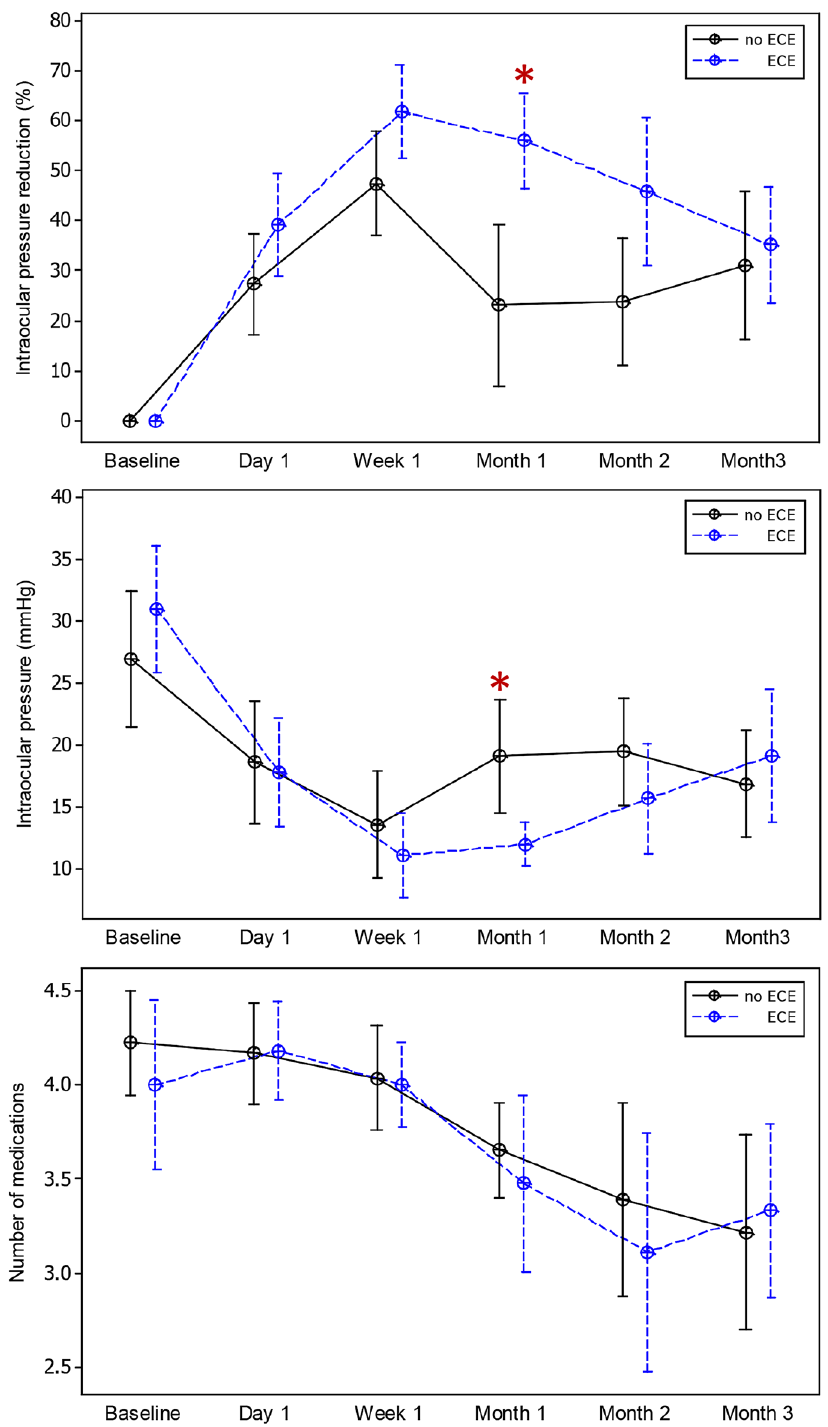
Figure 2. Interval plots of micropulse transscleral laser therapy outcomes during 12 weeks. (Top) intraocular pressure reduction, (Middle) absolute intraocular pressure, (bottom) number of glaucoma medications. Asterisk indicates statistically significant